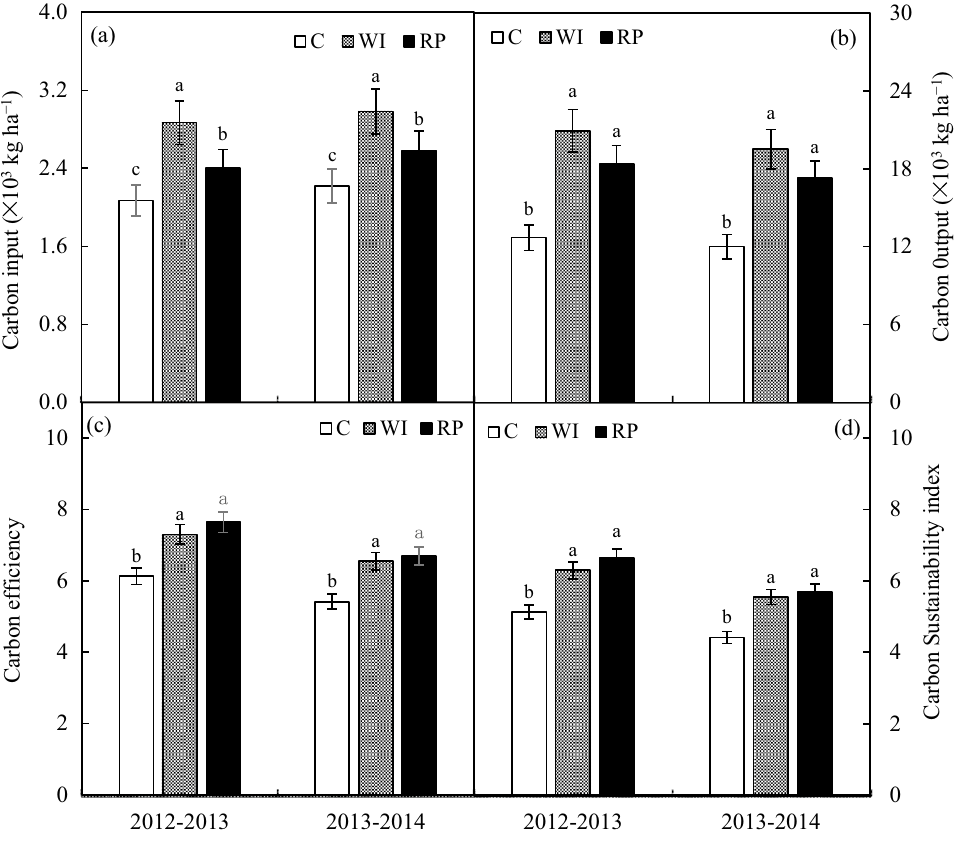
Figure 4. Effect of different planting strategies on carbon input ( a ), carbon output ( b ), carbon efficiency ( c ) and carbon sustainability index ( d ) of wheat–maize cropping system.